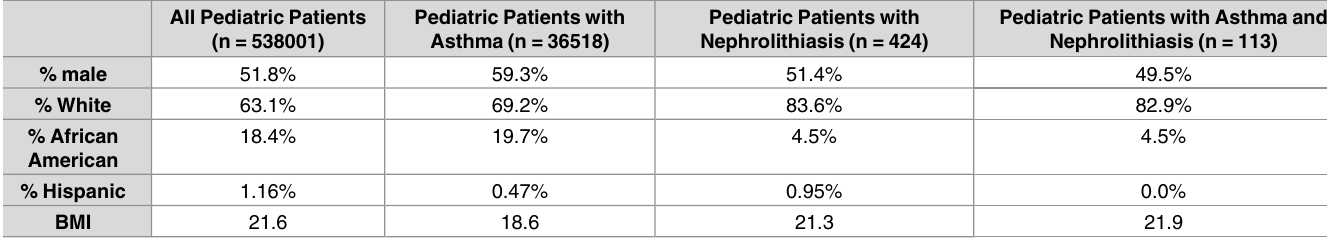
Table 1. Clinical-Demographic data for current pediatric patients stratified by asthma and kidney stone diagnosis. All Pediatric Patients Pediatric Patients with Pediatric Patients with Pediatric Patients with Asthma and (n = 538001) Asthma (n = 36518) Nephrolithiasis (n = 424) Nephrolithiasis (n =